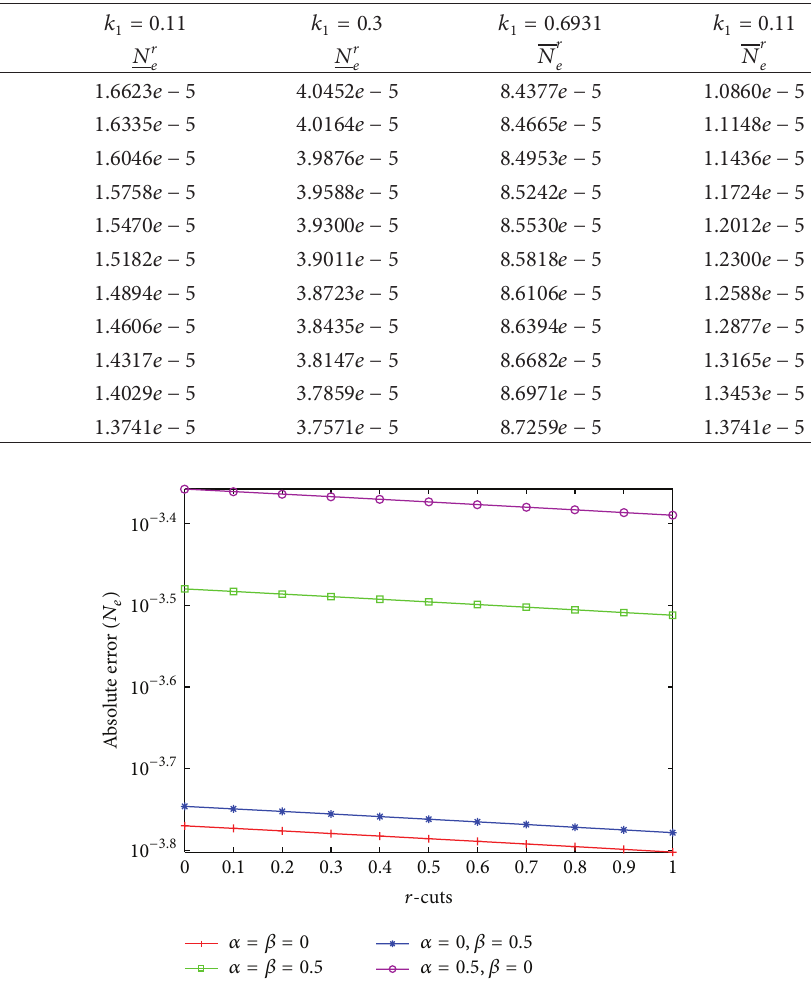
Figure 2: The absolute errors for different 𝛼 and 𝛽 with 𝑁 = 9 , 𝑘 1 = 0.3 and V = 0.75 , Case I.